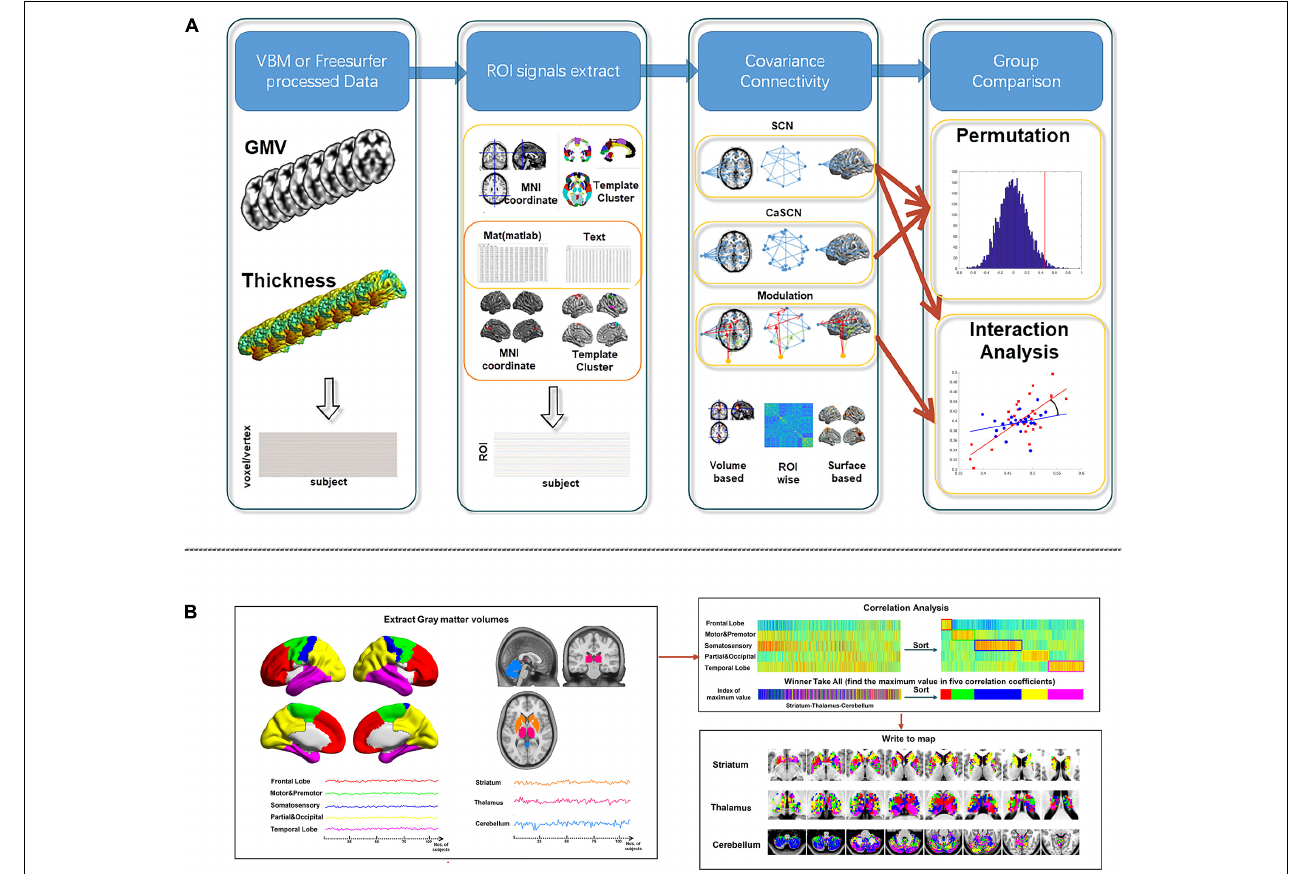
FIGURE 2 | Workflow of BCCT toolkit. (A) Workflow of SCN, CaSCN, and modulation analysis of structural covariance network (MOD-SCN). (B) Workflow of winner-take-all and cortex–subcortex covariance network (WTA-CSSCN). Here, the gray matter volume (GMV) from VBM/CAT12 could be used for the voxel-wise seed-to-brain analysis of volume-based morphological images and region of interest (ROI)-wise analysis of volume-based morphological images. The thickness from FreeSurfer could be used for the vertex-wise seed-to-brain analysis of surface-based morphological images.